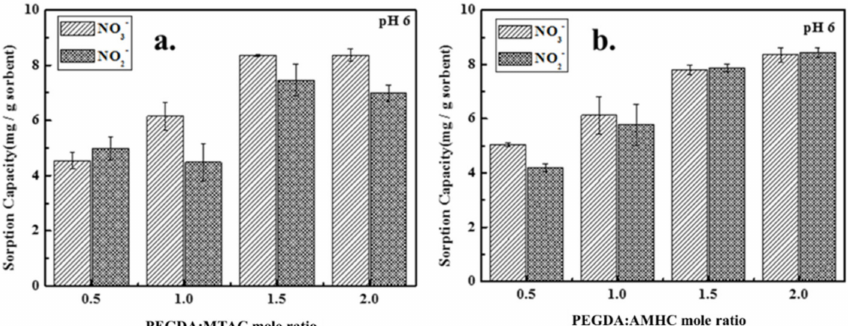
Figure 4. Concentration effect of modifier (MTAC or AMHC) toward adsorption capacity of nitrate and nitrite. ( a ) PEGDA–MTAC within 0.5, 1, 1.5, 2.0 (PEGDA: MTAC); ( b ) PEGDA–AMHC within 0.5, 1, 1.5, 2.0 (PEGDA: AMHC) (initial concentration of 50 mg N/L, pH = 6 and room temperature).